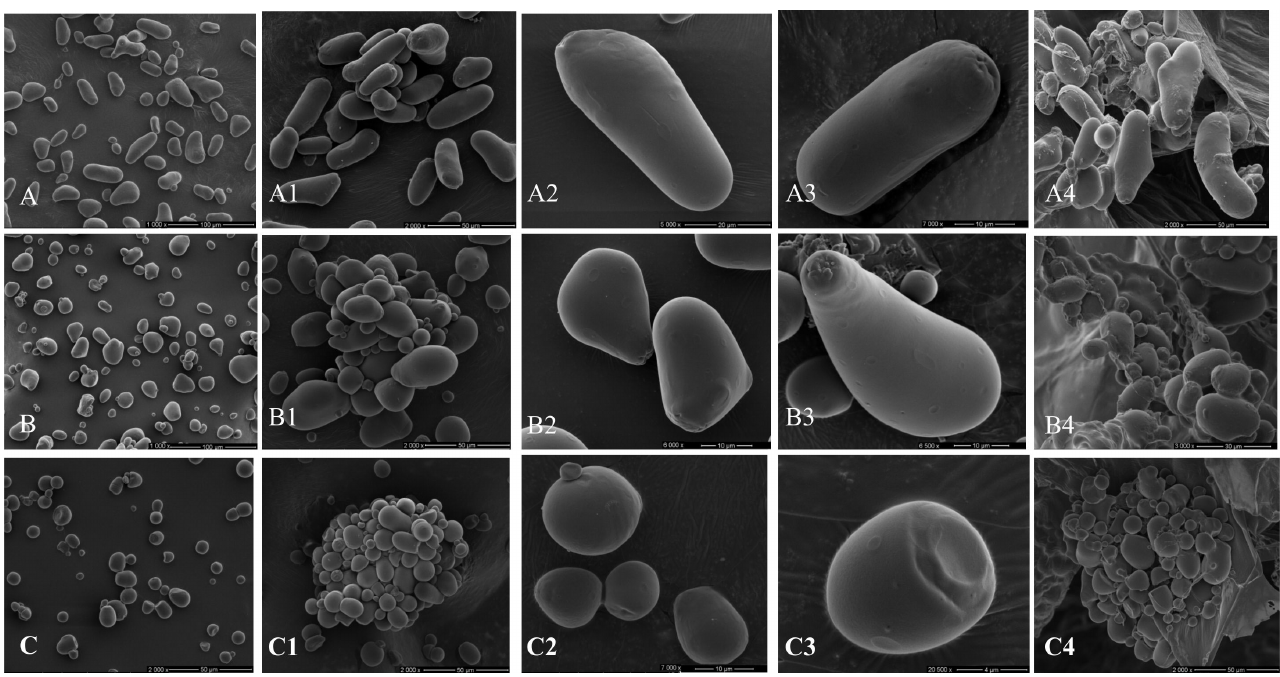
FIGURE 1 - SEM of isolated starches from oca (A-A3), olluco (B-B3) and mashua (C-C3). Images A4, B4 and C4 are from the respective freeze-dried